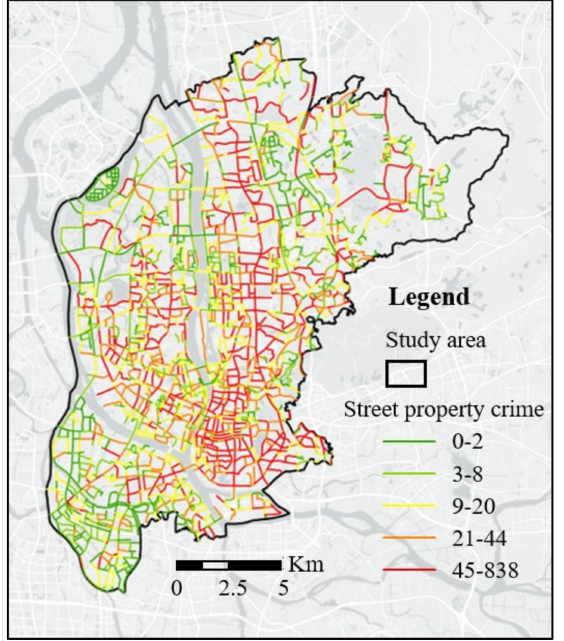
Figure 1. The spatial distribution of the number of street property crimes at the street segment level.